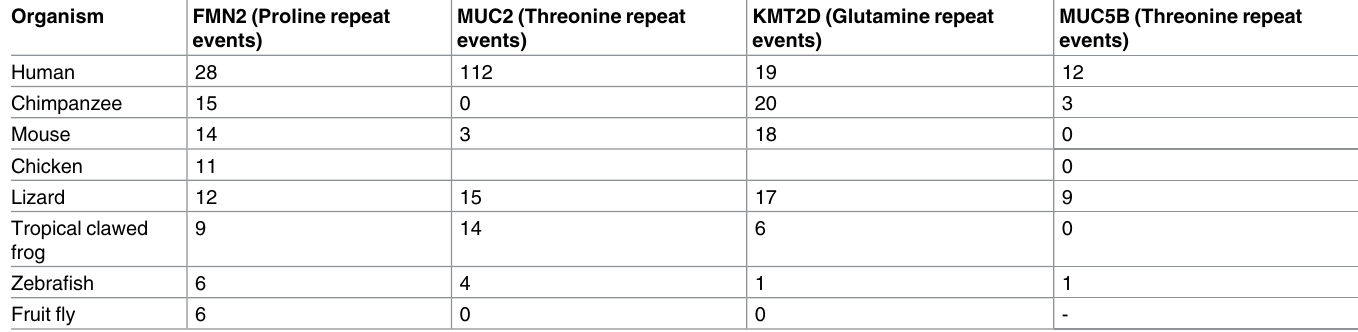
Table 3. Protein orthologs for SAAR containing proteins among animals (one event is a mono aminoacid stretch of (cid:21) 5 residues).